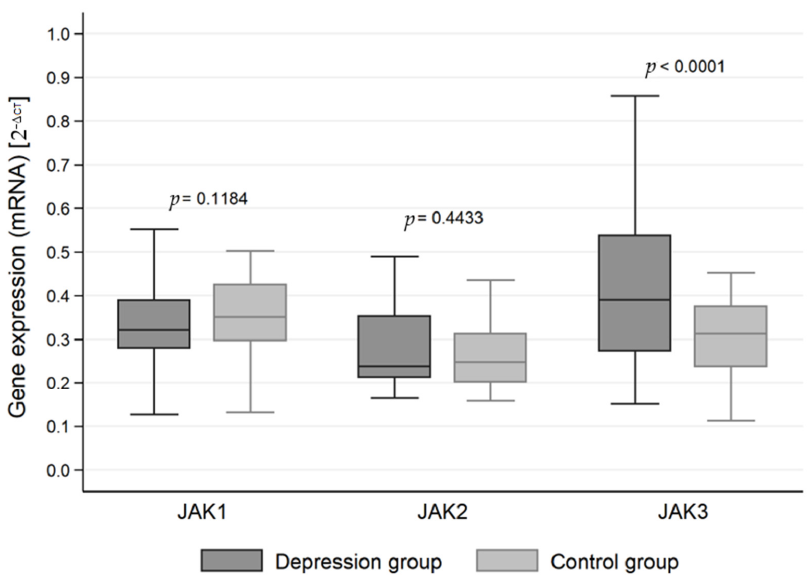
Figure 1. Expression of Janus kinase (JAK) genes at the mRNA level in the depression and healthy control group.